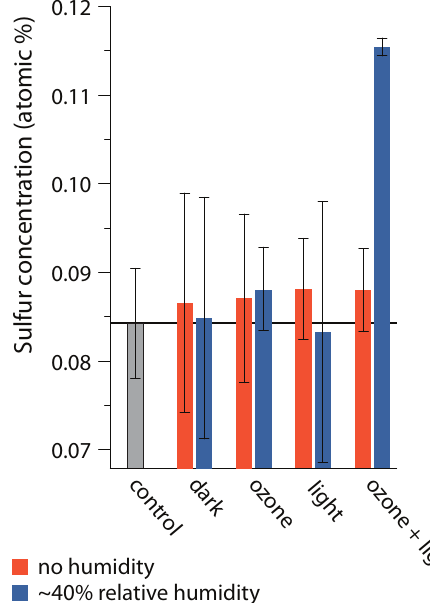
Fig. 4. Quantification of sulfate addition to mineral dust from sur- face SO 2 oxidation. “Control” shows the amount of sulfate present in untreated dust, and the labels on the x -axis refer to the different experimental conditions under which SO 2 was exposed to the dust. Error bars are the 1 σ standard deviation from the Poisson distribu- tion depending on the number of points with a significant